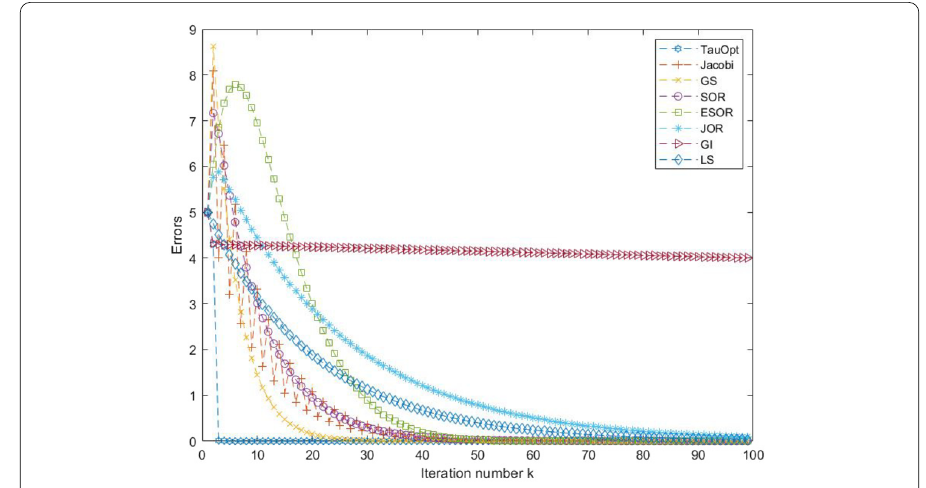
Figure 1 Error for Ex. 4.1